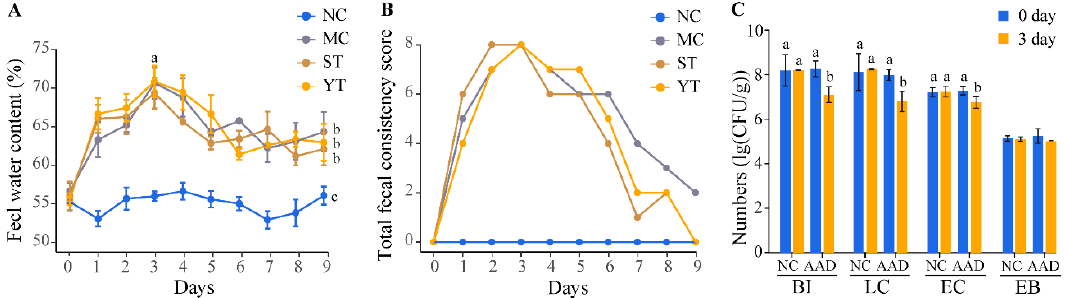
Figure 5. Symptoms of antibiotic-associated diarrhea. ( A ) The transition of fecal water content from each treatment group over the experimental period. ( B ) Total fecal consistency score for each treatment group during the study. ( C ) Fecal culture of normal control mice and antibiotic-associated diarrhea mice pre- and post- lincomycin hydrochloride modeling. BI, Bifidobacteria ; LC, Lactobacilli ; EC, Enterococcus ; EB, Enterobacteriaceae; NC, Normal control group ( n = 8); MC, Model control group ( n = 8); ST, DMST-H2 treatment group ( n = 8); YT, yogurt treatment group ( n = 8). Significance was set as p < 0.05, and values that do not share a common letter differed significantly ( p < 0.05).